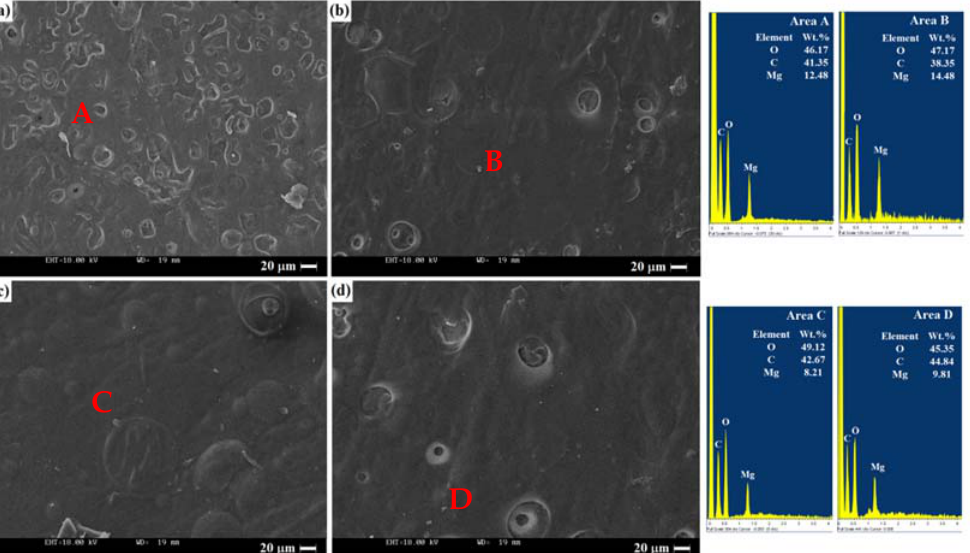
Figure 3. SEM images ( a ) CS, ( b ) CS/1MgO ‐ GO, ( c ) CS/2MgO ‐ GO, and ( d ) CS/3MgO ‐ GO coated Mg alloys, and corresponding EDX analysis of Areas A, B, C, and D.